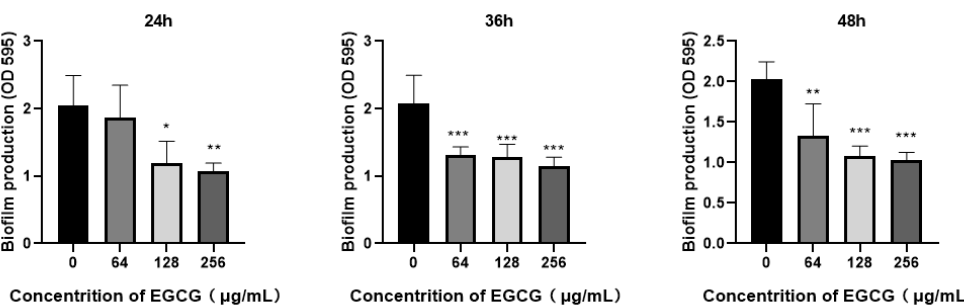
Figure 3. Concentration-dependent block effects of EGCG on P. aeruginosa biofilm formation. (All data are representative of three independent experiments performed in triplicate and expressed as the mean ± SD values in each bar. * p < 0.05; ** p < 0.01; *** p < 0.001).